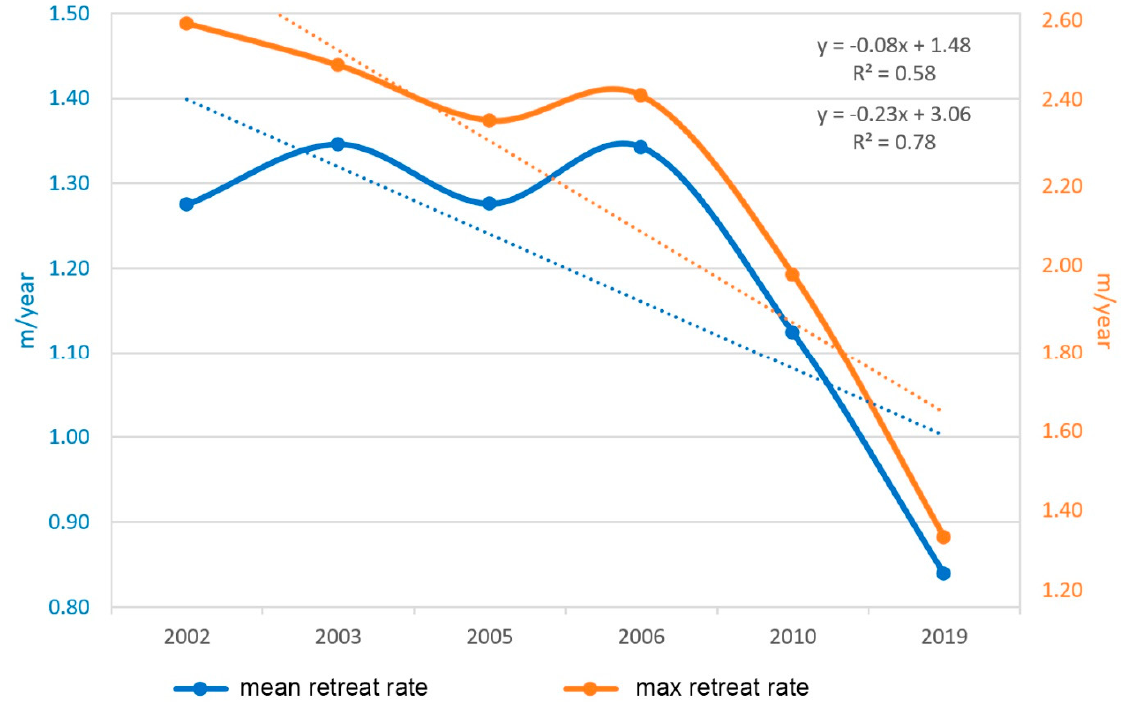
Figure 12. Evolution of the annual landslide scarp retreat rate at Site 2 since 2002, when high-precision instrumental fieldwork began.